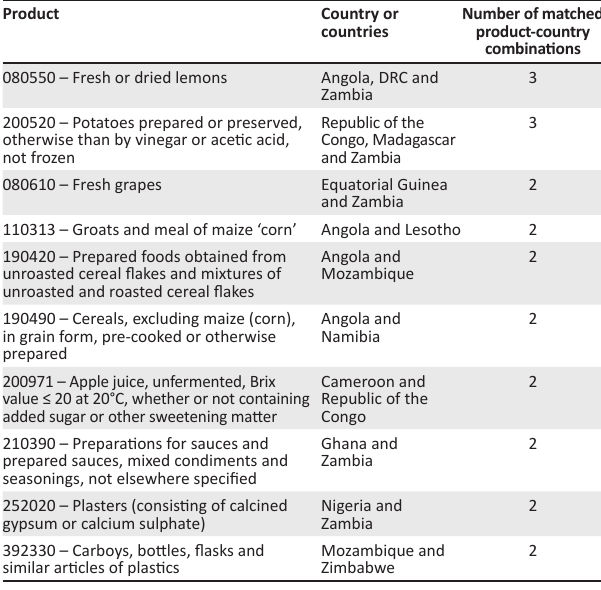
TABLE 4: Top 10 matched product-country combinations with utilised sustained export potential in SSA.